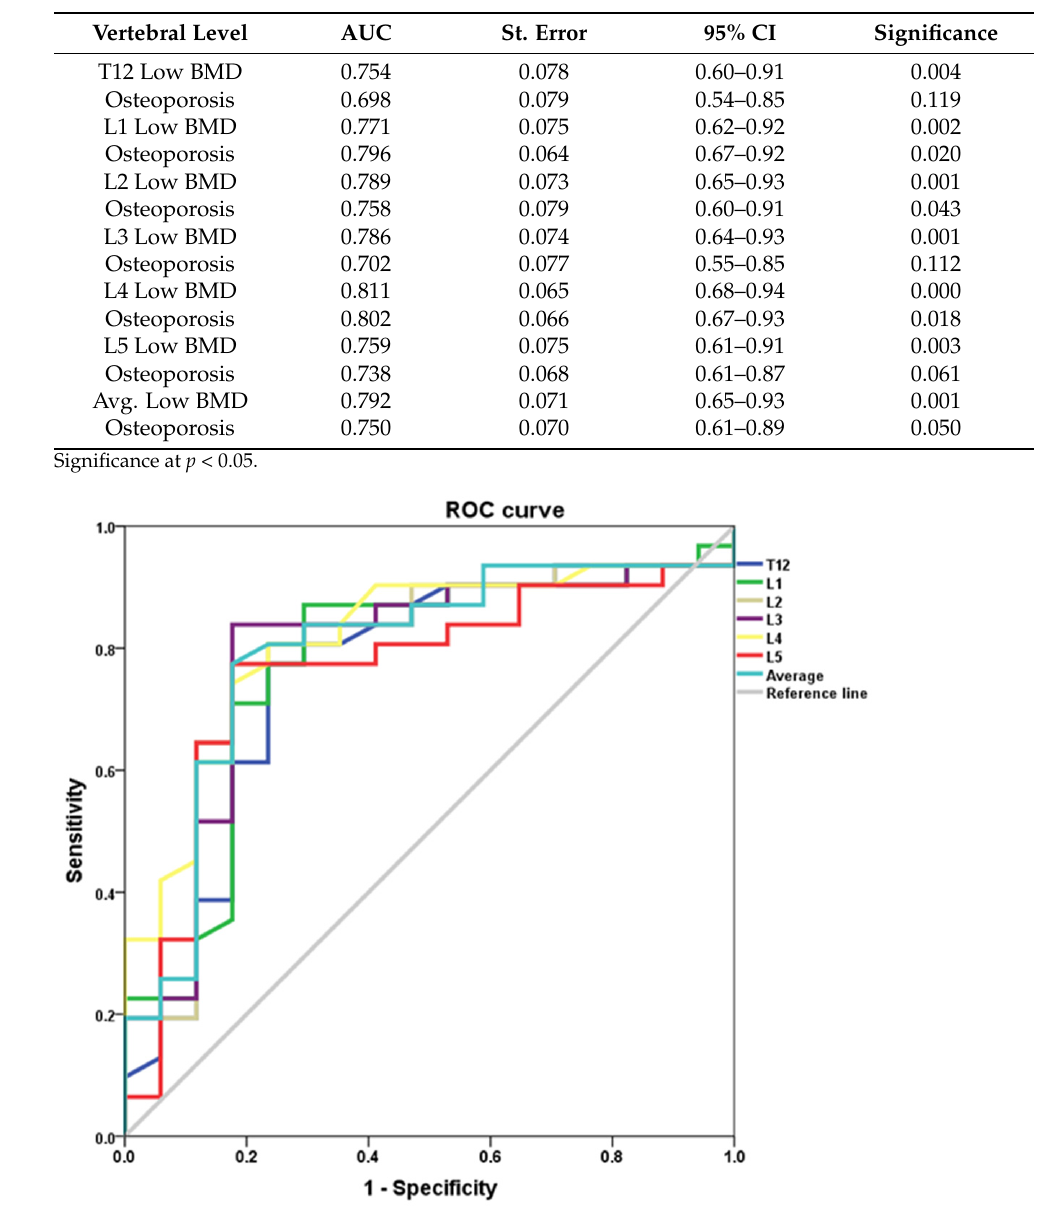
Figure 3. ROC curve for CT diagnosis of abnormally low bone density (osteopaenia and osteoporosis). The AUC results for diagnosing abnormally low BMD and osteoporosis for each vertebral level and the vertebral average are shown in Table.